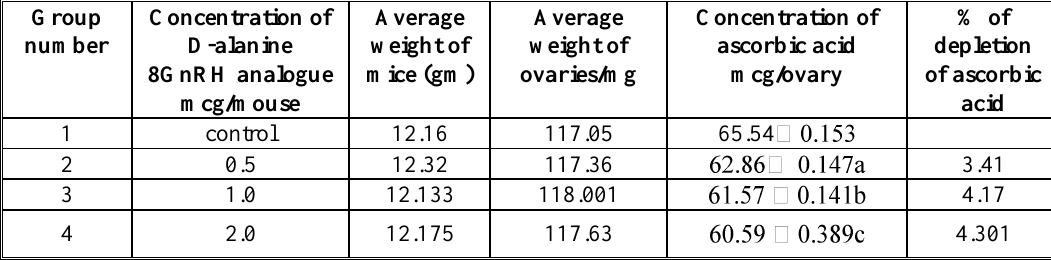
Table 4: Average weight of pseudo pregnant mice ovaries, concentration of ascorbic acid, and percent of depletion of ascorbic acid in the treated groups by analogue